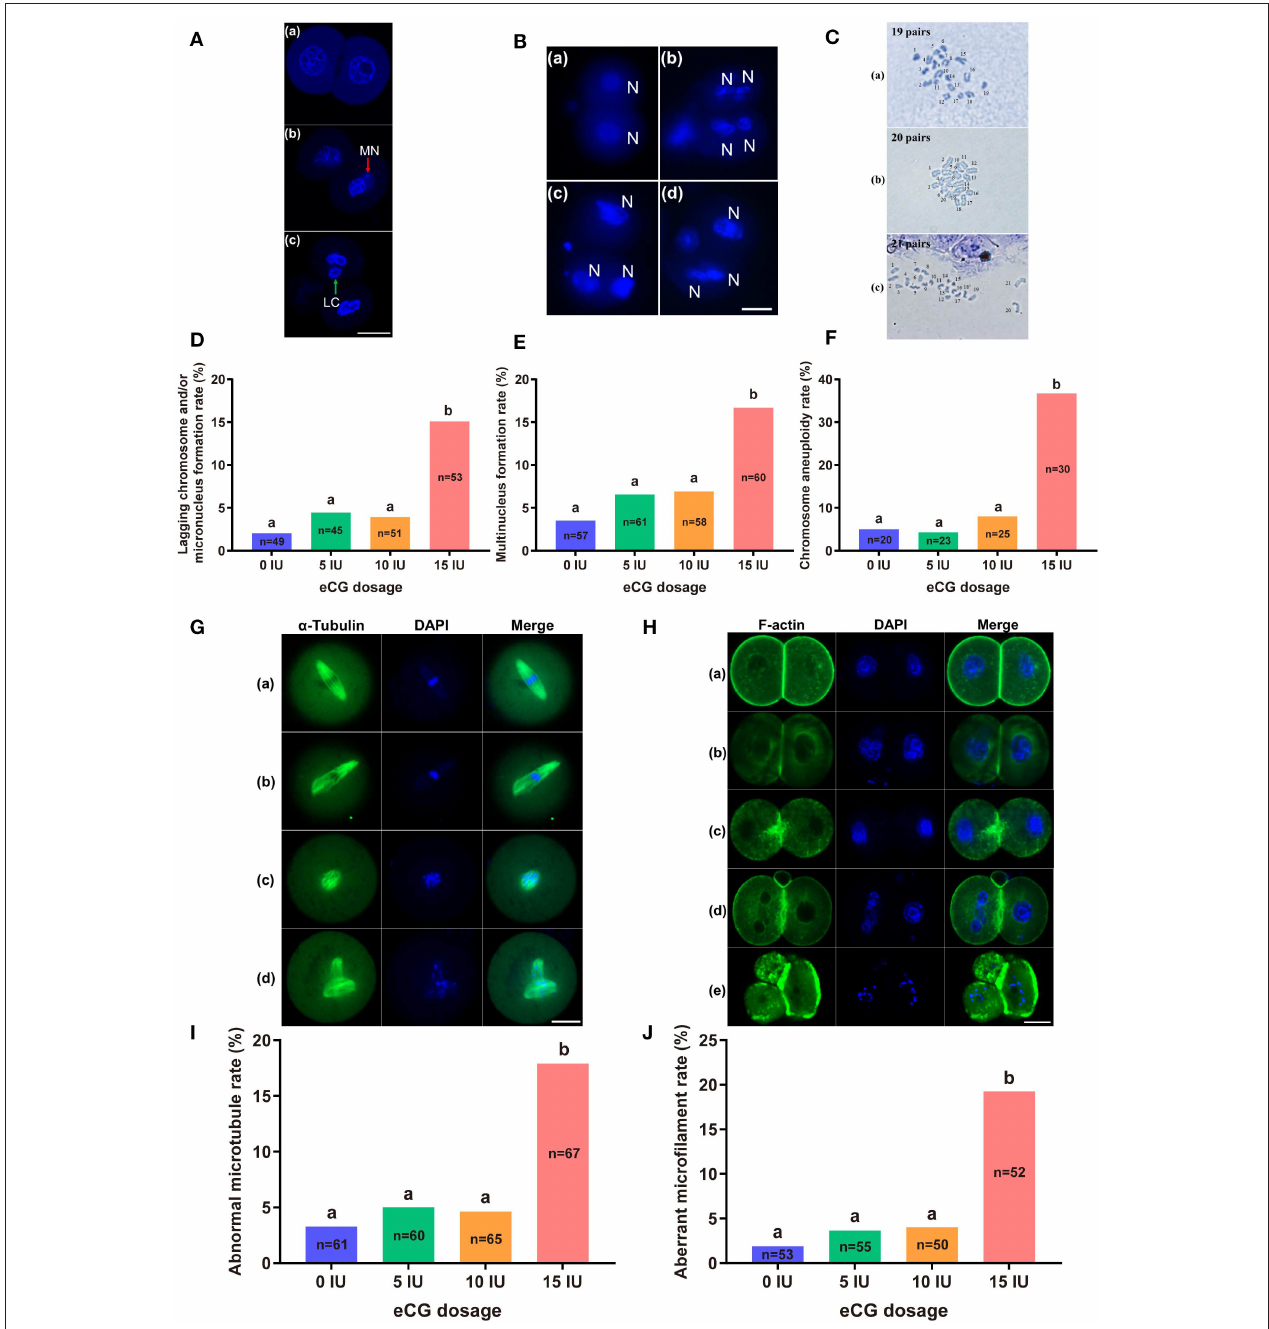
FIGURE 4 | Effects of different eCG doses on chromosome segregation and the cytoskeleton in IVF-derived mouse embryos during the first mitotic division. (A) Fluorescence photomicrograph of two normal daughter nuclei, micronuclei (red arrow) and lagging chromosomes (green arrow) (a–c, respectively) in IVF-derived mouse embryos during the first mitosis. Scale bar = 20 µ m. MN and LC refer to micronuclei and lagging chromosomes, respectively. (B) Representative images of two new daughter nuclei (a) and multinuclei (b–d). Scale bar = 20 µ m. N refers to nuclei. (C) Hypodiploidy: 19 pairs of chromosomes (a). Normal mice have 20 pairs of chromosomes (b). Hyperdiploidy: 21 pairs of chromosomes (c). (D–F) Bar graphs of the lagging chromosome and/or micronucleus formation rates, multinucleus formation rates, and chromosome aneuploidy rates for the four groups. (G) Confocal images of a normal spindle structure and shape (a) and abnormal spindle formation (b–d). Mouse embryos at metaphase were stained with anti- α -tubulin antibodies (green) to detect microtubules, namely, the spindle. Scale bar = 20 µ m. (H) Mouse embryos were stained with Alexa Fluor TM 488 phalloidin (green) to visualize the configuration and distribution of microfilaments. Normal microfilaments were precisely located in the cell cortex around the contractile ring at telophase (a). Representative images of aberrant microfilament formation (b–e). Scale bar = 20 µ m. (I,J) Bar graphs of the abnormal microtubule rates and aberrant microfilament rates, respectively. Different lowercase letters in the columns within each parameter indicate significant differences ( P < 0.05). The nuclei were stained with DAPI (blue), and n shows the total number of embryos detected.